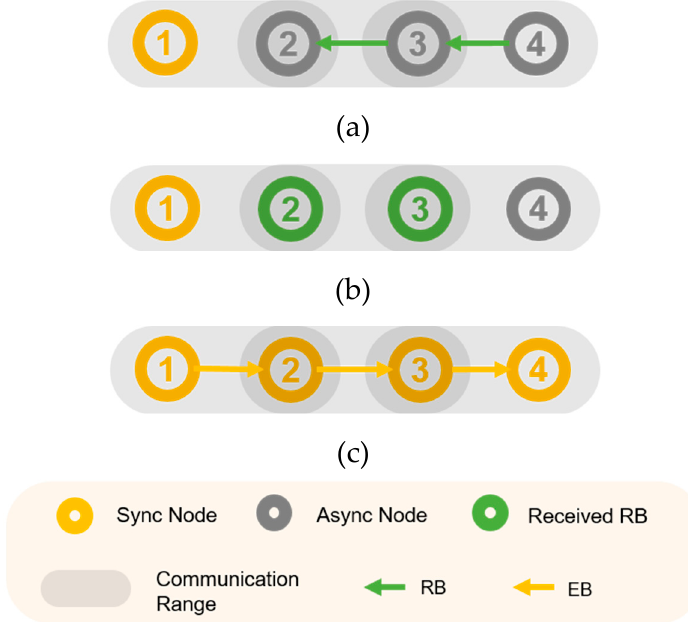
Figure 3. Example PRV–TSCH ( a ) Nodes 3 and 4 send RB ( b ) Nodes 2 and 3 receive RB ( c ) Fast synchronization using rendezvous packets.